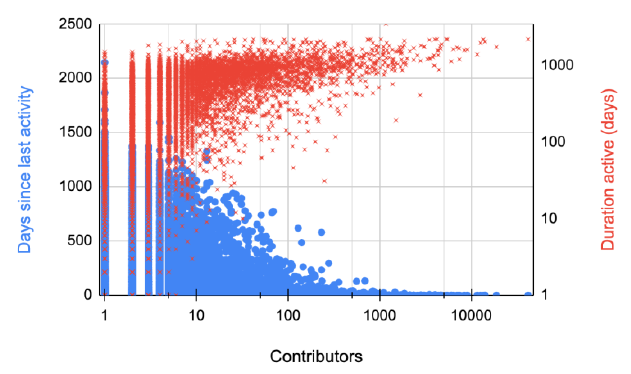
Figure 18: Number of GitHub Blockchain-related project contributors compared to the number of days since the projects’ last activity and the project active